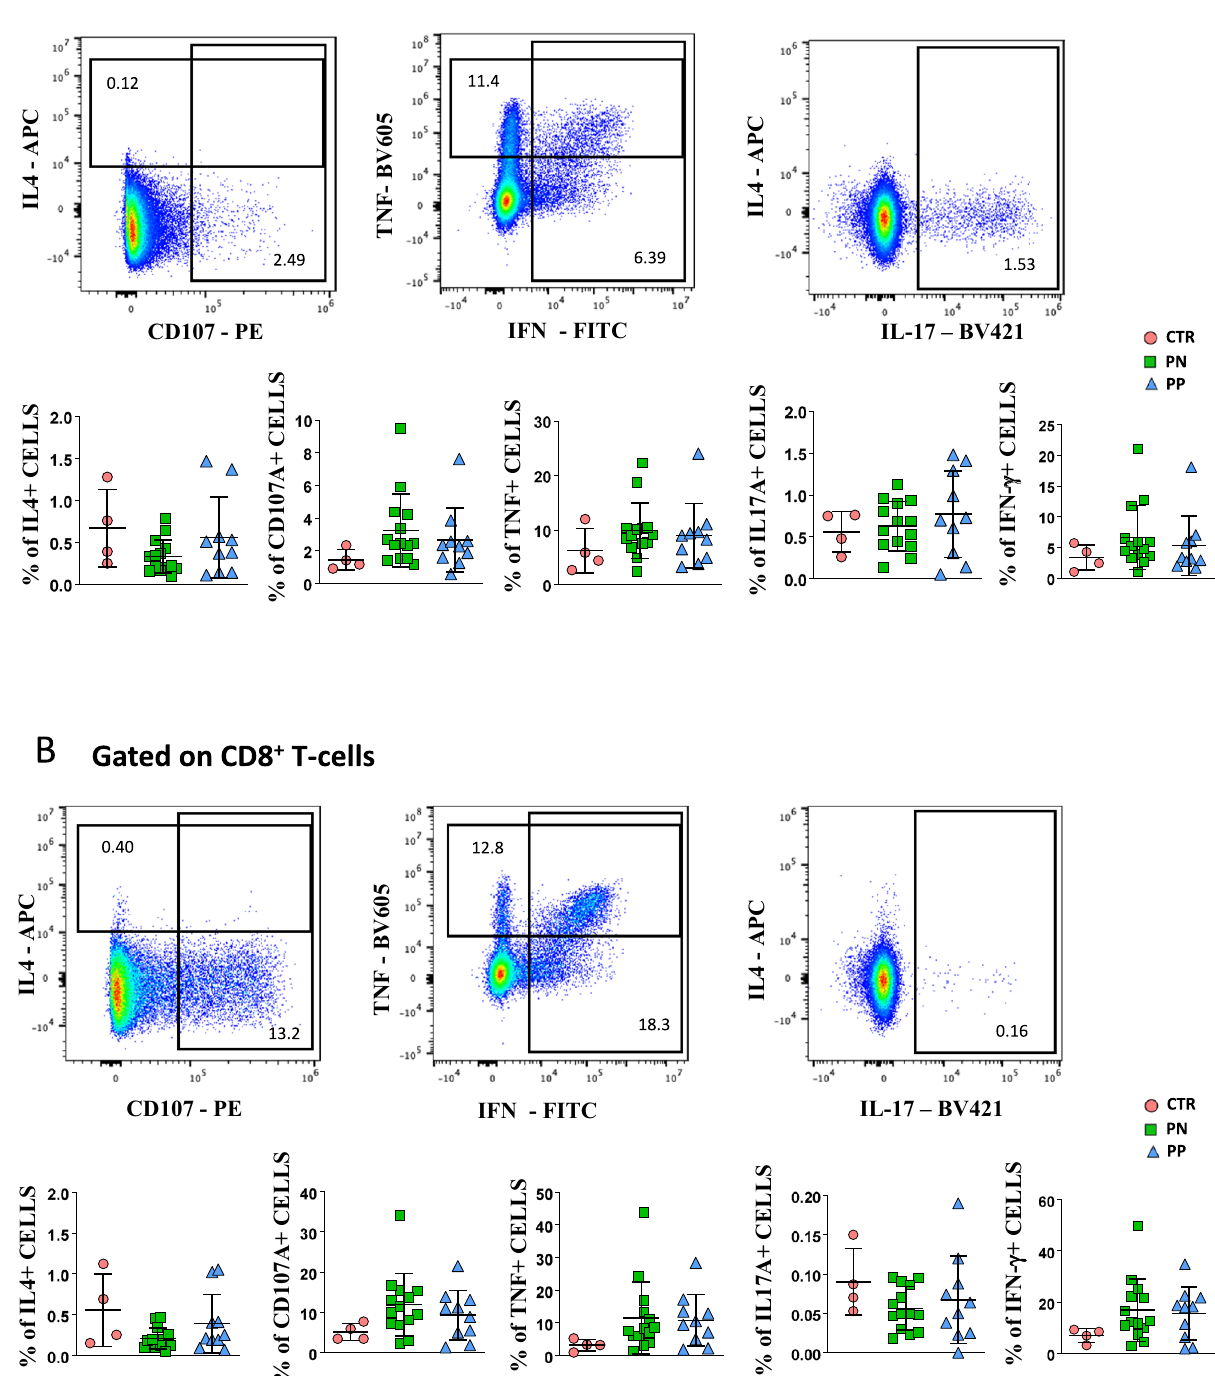
Fig. 8 Functional characterization of CD4 and CD8 T cells of COVID-19 pregnant women. A Comparison among the three groups of persons under investigation regarding the production of cytokines by CD4 + T cells after in vitro stimulation with anti-CD3/CD28. Data represent individual values from healthy donors (CTR, n = 4), pregnant negative (PN, n = 14), and pregnant positive (PP, n = 10), mean (center bar) ± standard deviation (upper and lower bars). Values (dots) for the three conditions are matched with the color used in Figs. 1 – 5. Data represent individual percentage values (dots), mean (center bar), and standard deviation (upper and lower bars). Two-tailed Mann – Whitney t test with Bonferroni correction has been used. The exact p value is indicated in the fi gure, if signi fi cant. B Comparison among the three groups of persons under investigation regarding the production of cytokines by CD8 + T cells after in vitro stimulation with anti-CD3/CD28. Data represent individual values from healthy donors (CTR, n = 4), pregnant negative (PN, n = 14), and pregnant positive (PP, n = 10), mean (center bar) ± standard deviation (upper and lower bars). Values (dots) for the three conditions are matched with the color used in Figs. 1 – 5. Data represent individual percentage values (dots), mean (center bar), and SD (upper and lower bars). Two-tailed Mann – Whitney U -test with Bonferroni correction has been used. The exact p -value is indicated in the fi gure, if signi fi